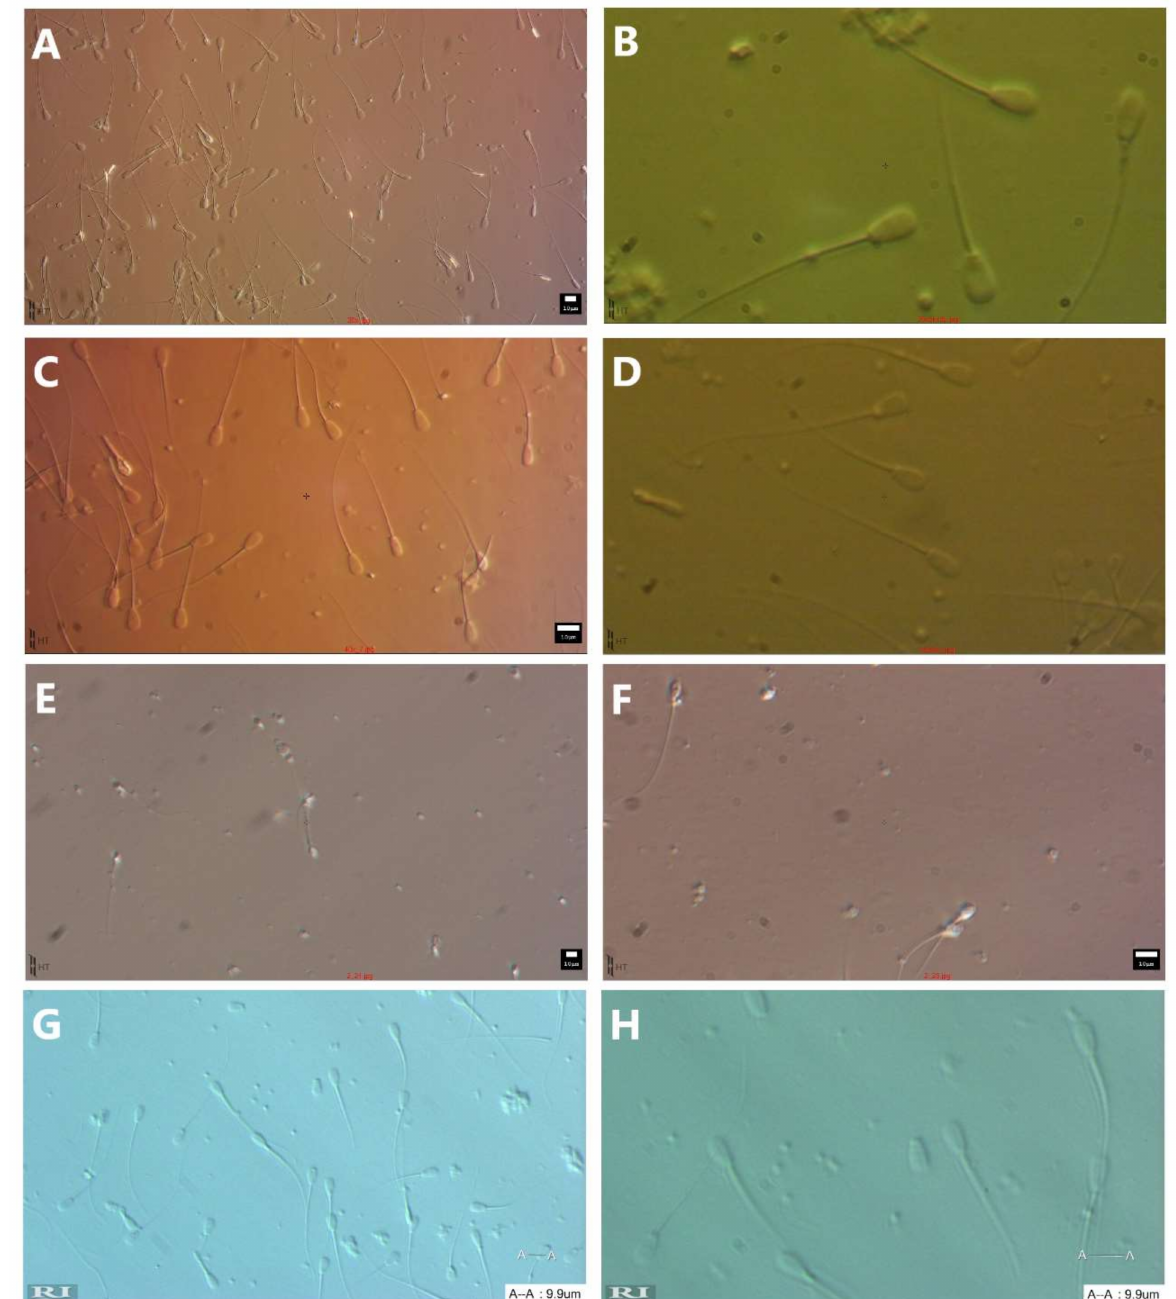
Figure A4. Photos of spermatozoa with different modulation contrasts with an objective NA be- tween 0.45 and 0.6 and a condenser NA between 0.4 and 0.6, no filter. ( A ) Hoffman modula- tion contrast—objective Nikon ELWD 20 × NA 0.45, condenser NA 0.6, (total magnification 200 × ), ( B ) Hoffman modulation contrast—objective Nikon ELWD 40 × NA 0.55, condenser NA 0.6, (total magnification 1000 × ) optical magnification 2.5 times within ocular tube head (T-TD), ( C ) Hoffman modulation contrast—objective Nikon ELWD 40 × NA 0.55, condenser NA 0.6, (total magnification 400 × ), ( D ) Hoffman modulation contrast—objective Nikon ELWD 20 × NA 0.45, condenser NA 0.6, (total magnification 500 × ), ( E ) relief contrast—objective Olympus LUCPlanFLN 20 × NA 0.45, condenser NA 0.5, (total magnification 200 × ), ( F ) relief contrast—objective Olympus LUCPlanFLN 40 × NA 0.60, condenser NA 0.5, (total magnification 400 × ), ( G ) PlasDIC—Zeiss, objective LD Plan- Neofluar 20 × NA 0.4 condenser NA 0.55, (total magnification 200 × ), ( H ) PlasDIC—Zeiss, objective LD Plan-Neofluar 40 × NA 0.6 condenser NA 0.55, (total magnification 400 ×